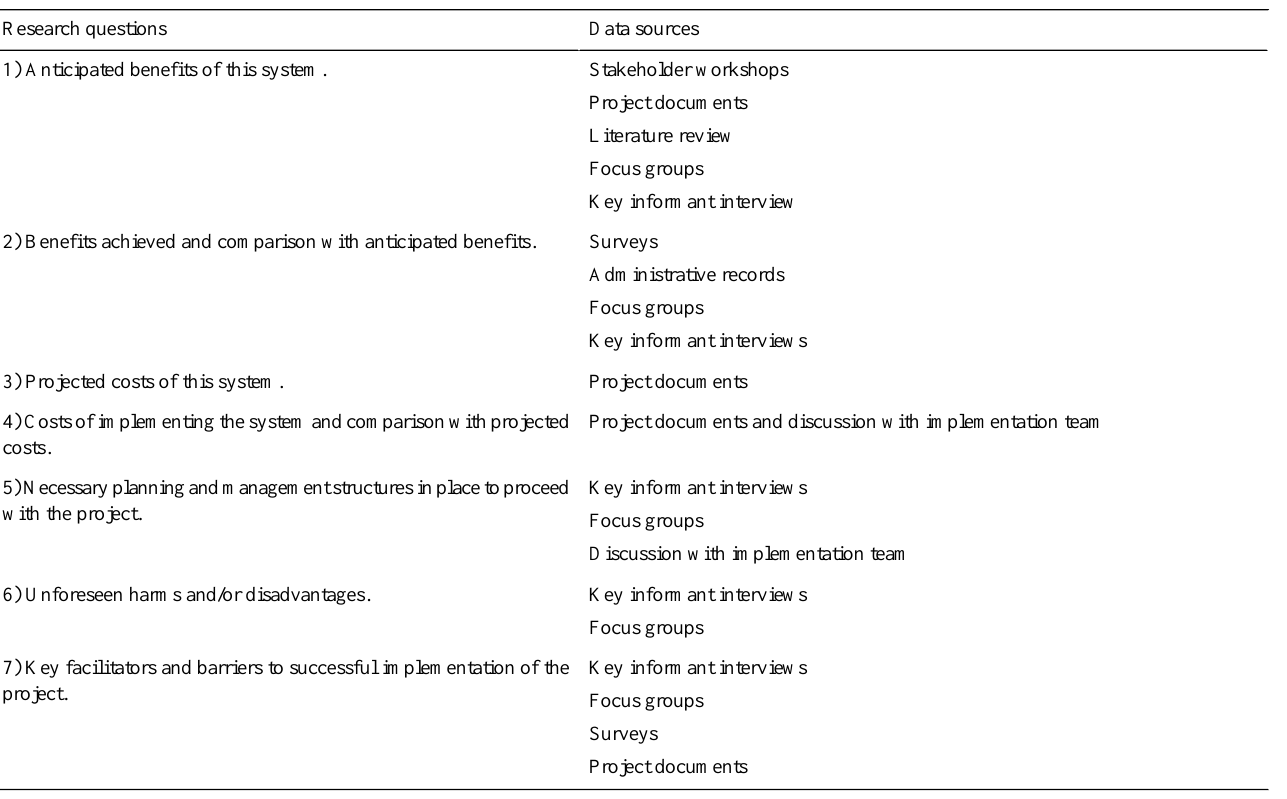
Table 1. Research questions and data sources